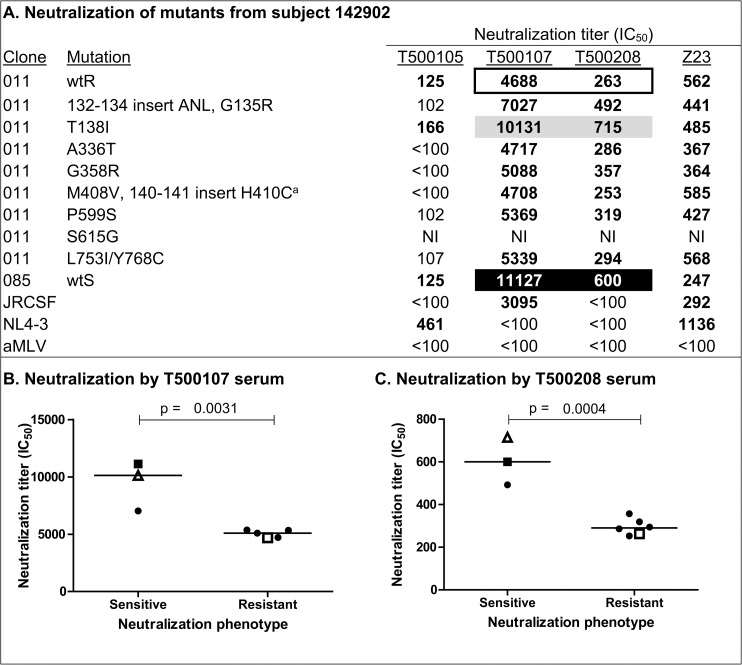
Mutational analysis to map residues responsible for differences in neutralization sensitivity and resistance in Envs from subject 142902.Amino acids from the neutralization-sensitive clone (085) were systematically inserted into the neutralization-resistant Env (011). (A) Effect of amino acid polymorphisms on neutralization by plasma from four HIV-1 infected subjects. The neutralizing antibody titer (IC50) is defined as the reciprocal of the plasma dilution that produces a 50% inhibition in target cell infection. Values in bold represent significant neutralization titers that are at least three times greater than those observed against the negative control (aMLV). Panel A, open rectangle, indicates neutralization titers for the wildtype resistant (wtR) clone; black rectangle, indicates neutralization titers for the wildtype sensitive (wtS) clone; gray rectangle, indicates the single amino acid substitution that converted the neutralization-resistant Env into a neutralization-sensitive Env. NI, indicates a non-infectious mutant. Panels B and C represent graphs and statistical analysis of neutralization-sensitive and -resistant viruses with the T500107 and T500208 plasma, respectively. Panels B and C, closed square (■) indicates neutralization titers of wtS clone 085; open square (□) indicates neutralization titer of wtR clone 011. Open triangles (△) indicate neutralization titers of wtR clone 011 incorporating the T137I mutation. Closed circles (●) indicate neutralization by the other mutants listed in panel A. Statistical significance was calculated using an unpaired t test.